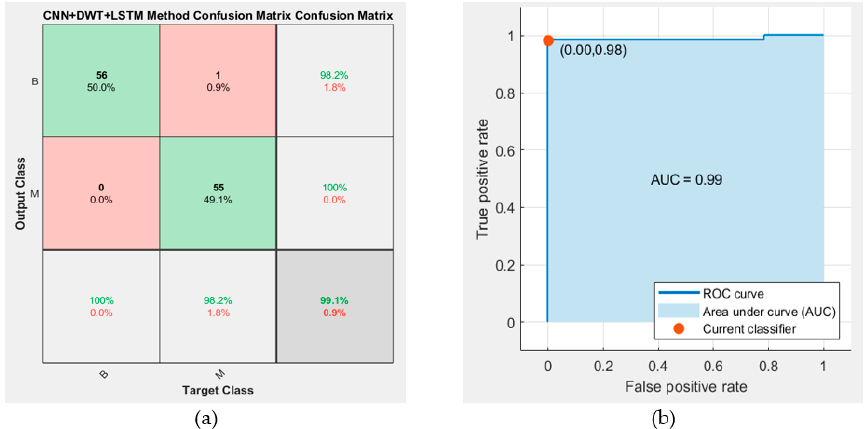
Figure 8. ( a ) Confusion matrix of proposed method; ( b ) Receiver operating characteristic (ROC) curve